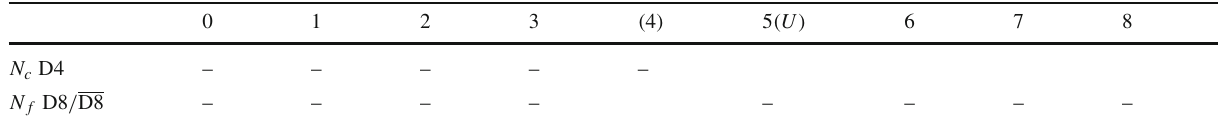
Table 1 The D-brane configurations: “–” denotes the world volume directions of the D-branes